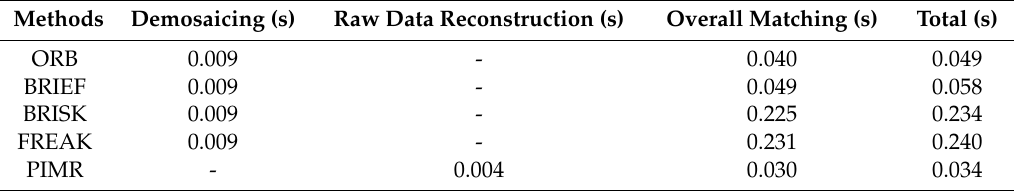
Table 1. Times of matching for the bikes image 1 and 3.